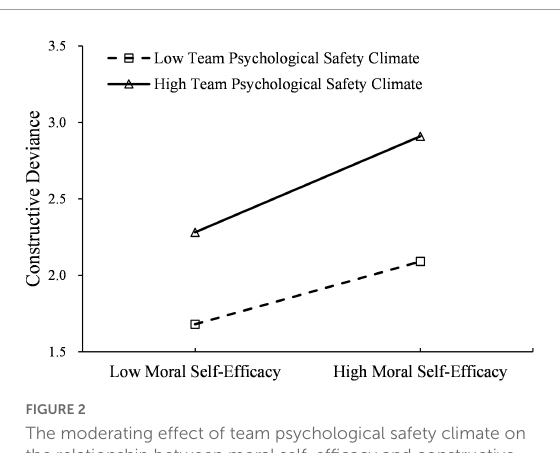
FIGURE2 The moderating effect of team psychological safety climate on the relationship between moral self-efficacy and constructive